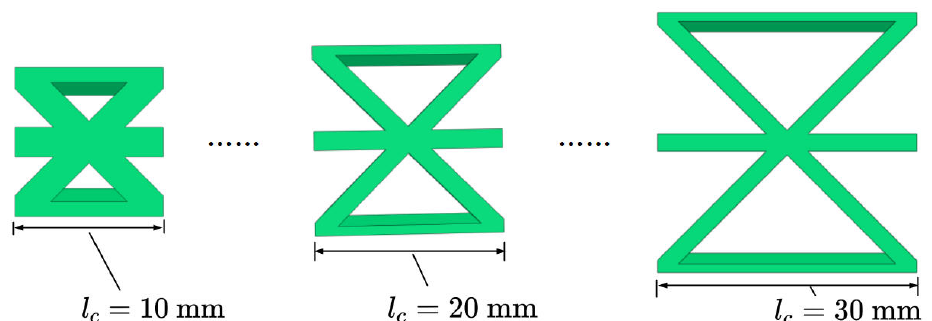
Figure 11. Geometric configuration of core cells with different cell side lengths.